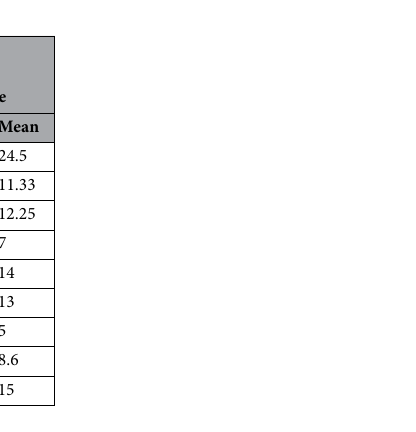
Table 3. The sum and mean of cis -elements for each